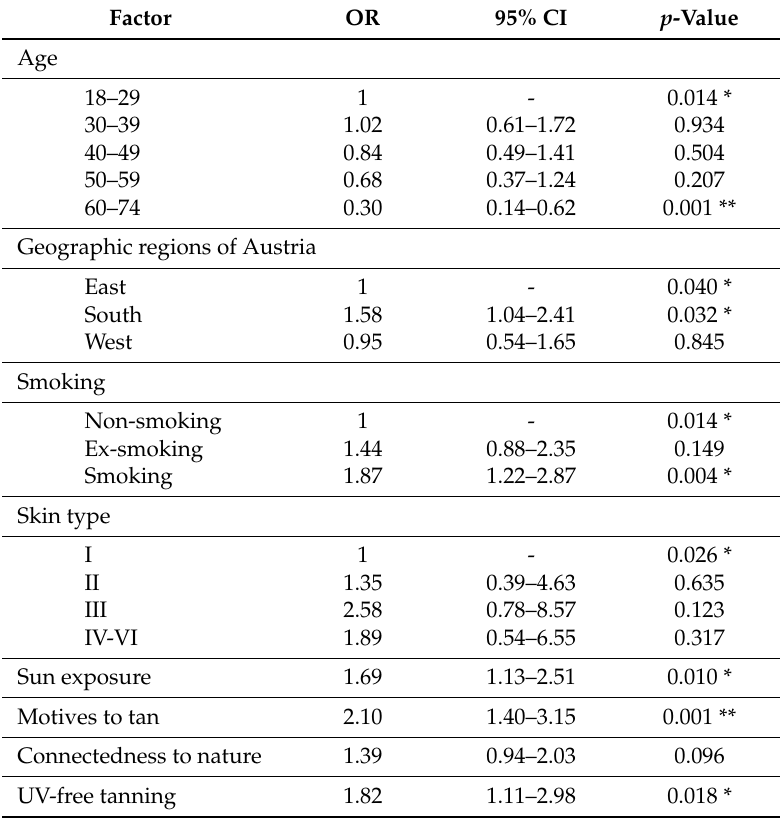
Table 5. Results of the linear regression analysis on sunbed